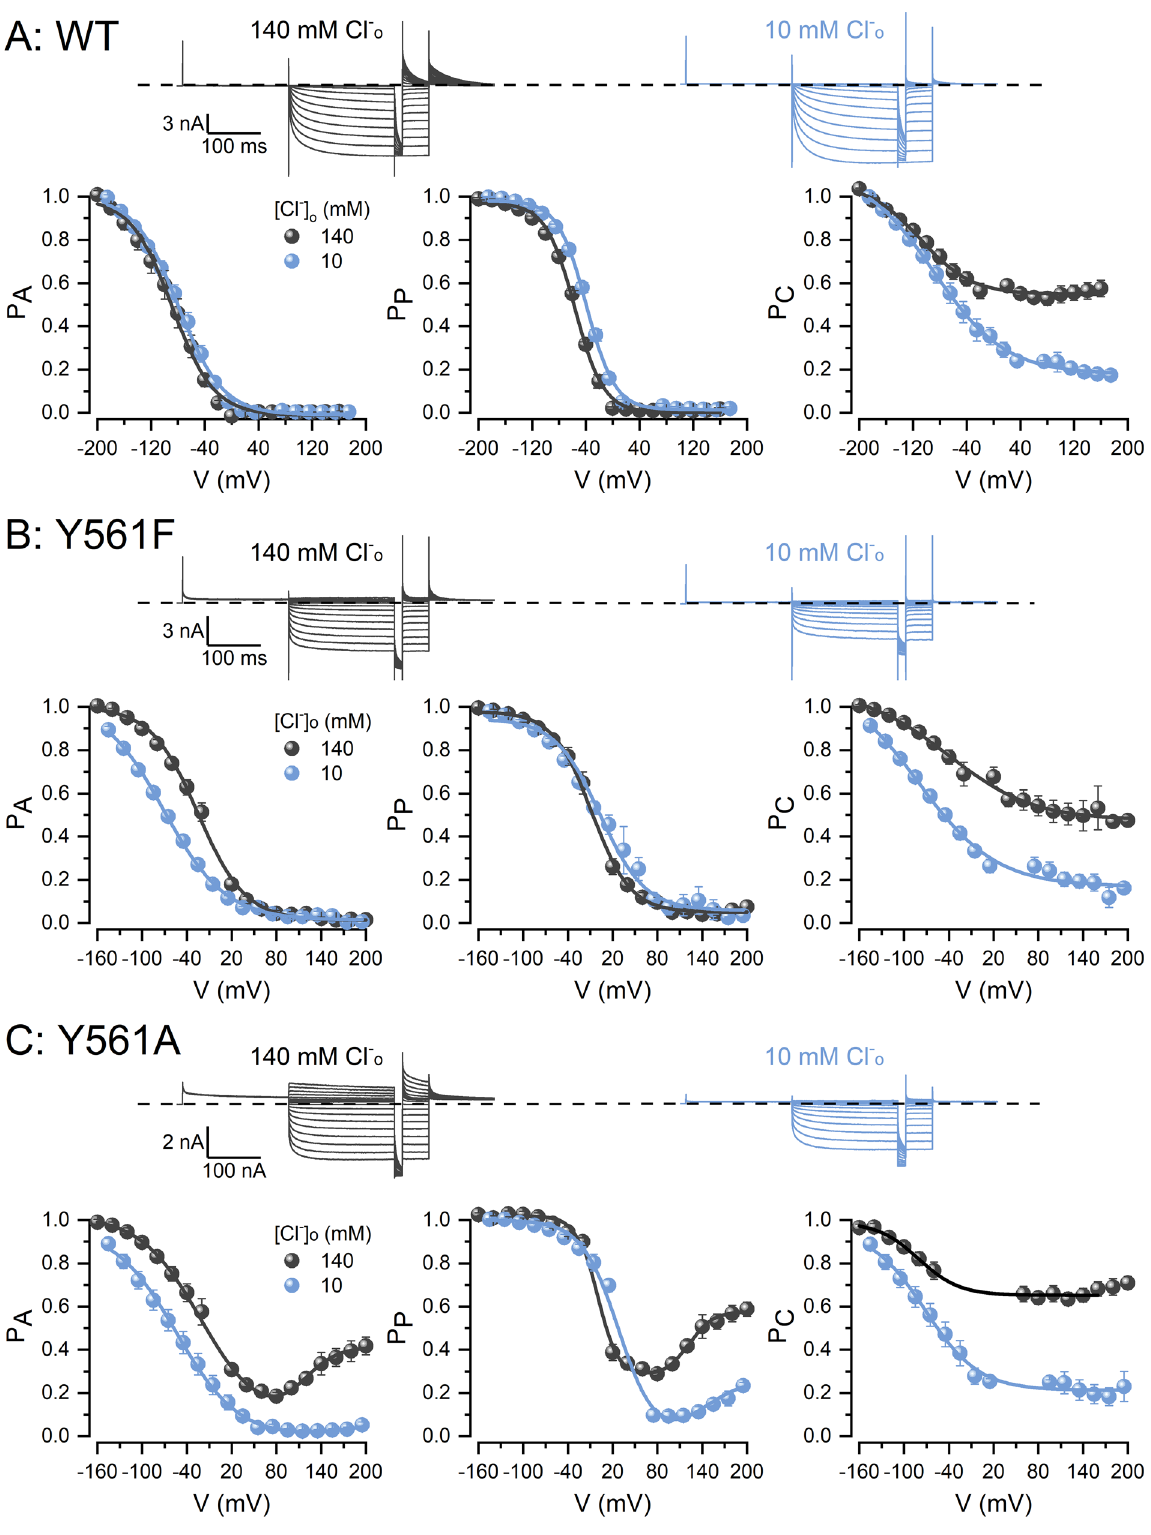
Figure 5. Y561F and Y561A CLC-2 mutant channels are sensitive to extracellular chloride. (A–C) Top panels: Cl − currents recorded from HEK293 cells expressing WT CLC-2 (A) , Y561F (B) , or Y561A (C) exposed first to 140 (grey) and then 10 (blue) mM [Cl − ] o . [Cl − ] i = 140 mM and pH i = pH o = 7.3. Channels were activated using the voltage protocol shown in Fig. 2A. (A–C) Bottom panels: Voltage dependence of P A (left), P P (middle), and P C (right) for WT CLC-2 (A) , Y561F (B) and Y561A (C) determined first with 140 (grey) and then with 10 (blue) mM [Cl − ] o . [Cl − ] i = 140 mM and pH i = pH o = 7.3. Lines are fits of the data with a single ( A,B , and P A from 10 mM Cl − data and P C in C ) or double (P A from 140 mM Cl − data and P P in C ) Boltzmann equation. Voltage-dependent parameters V 0.5 and z are listed in Table